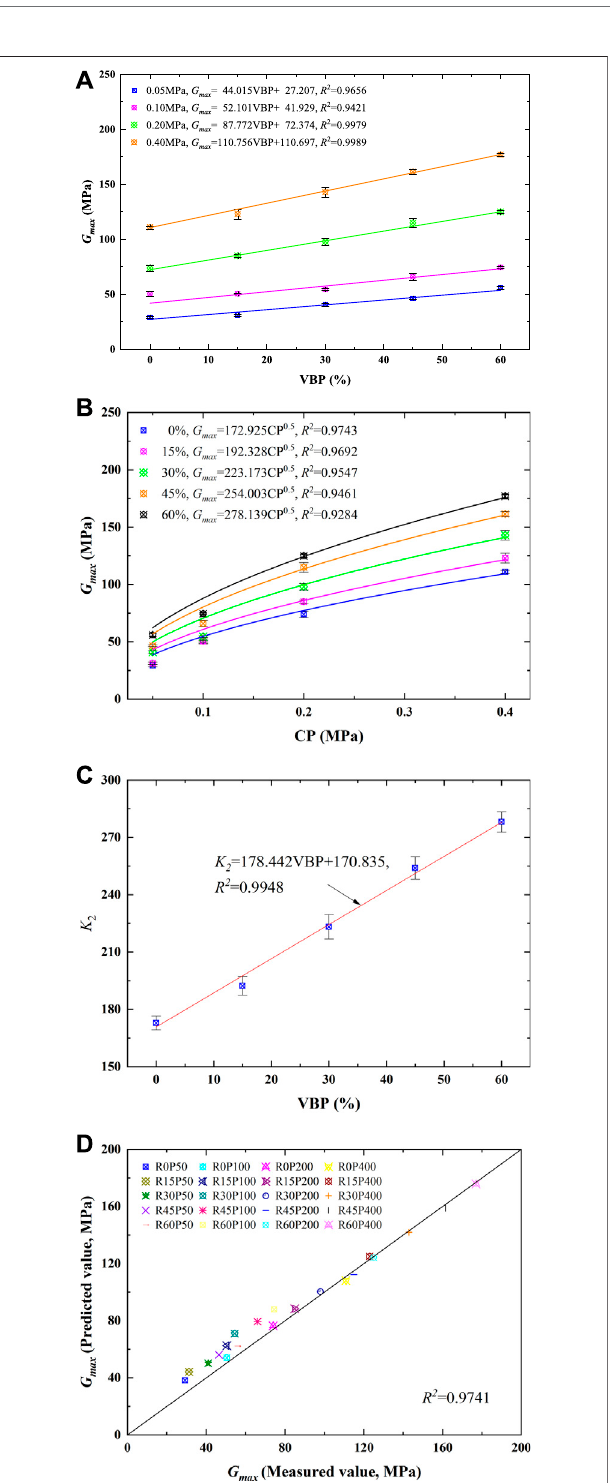
FIGURE 1 | Relationships of the G max of GSCGS with the VBP and CP.